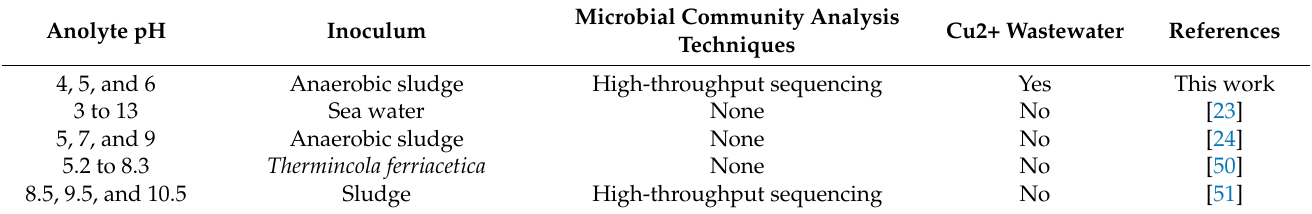
Table 2. Comparison of this work with other related studies.